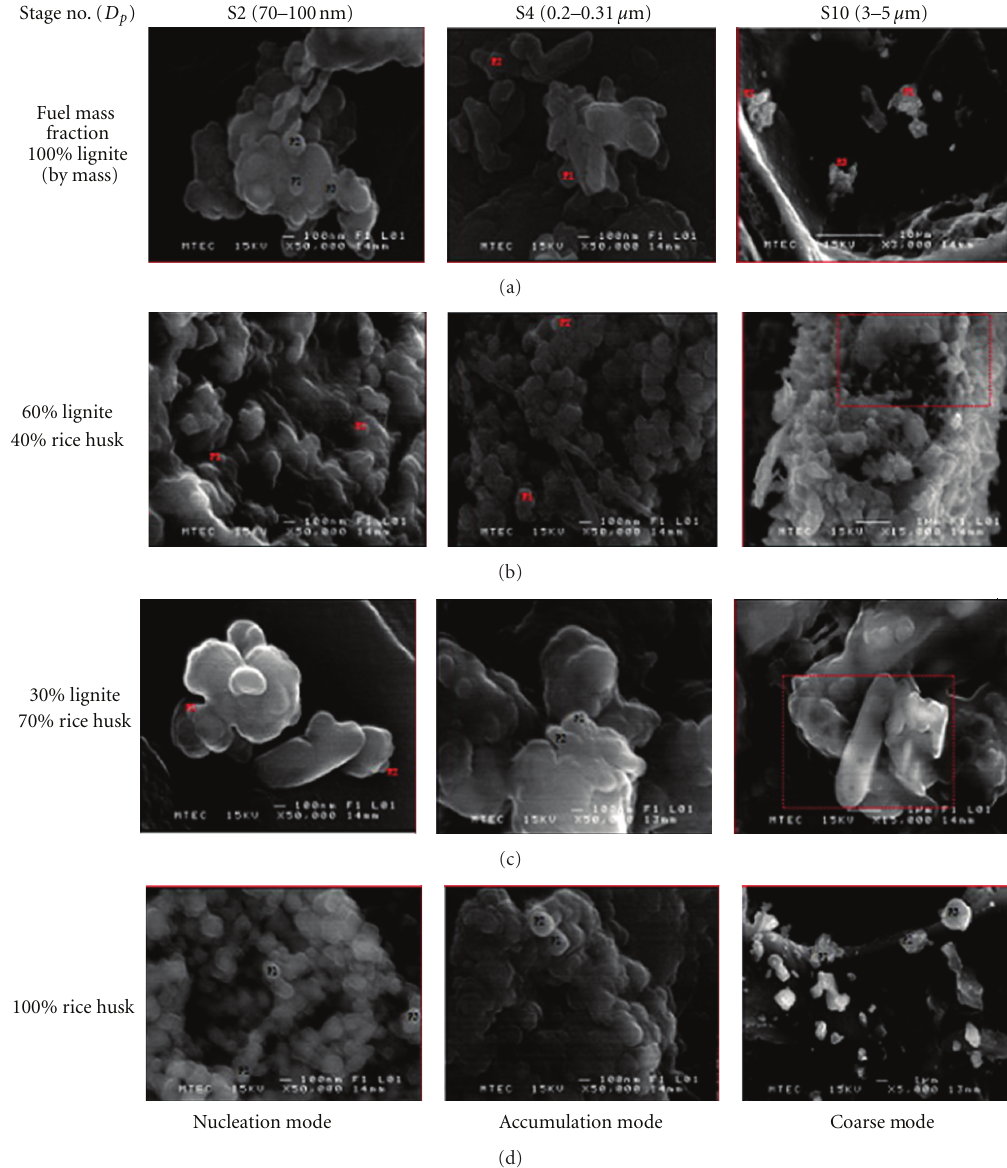
Figure 3: Particle